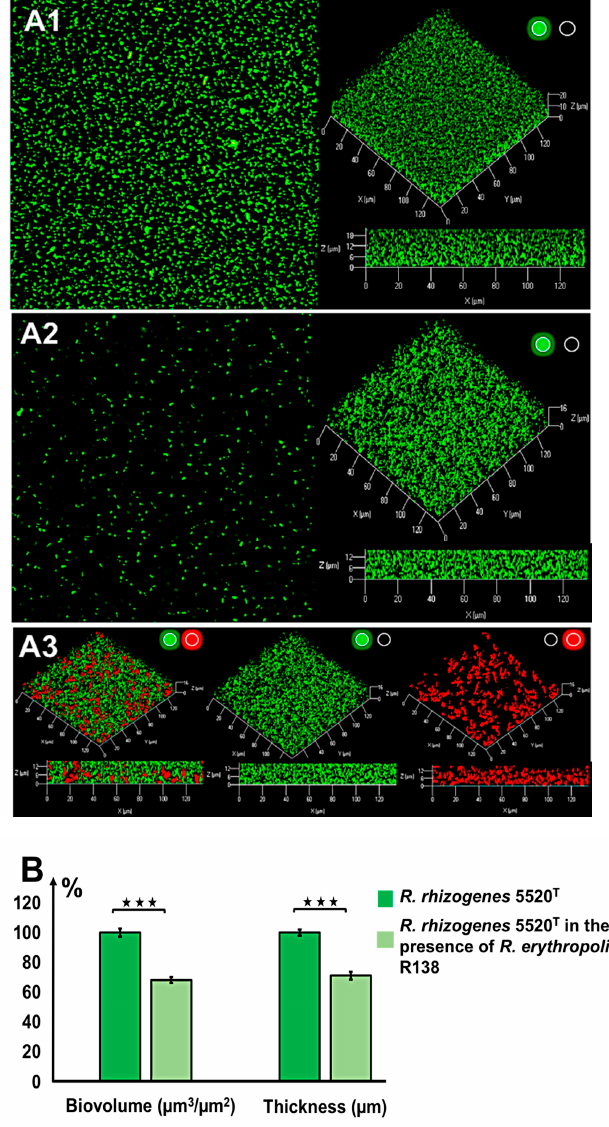
Figure 2. Inhibition of rhizobial biofilm formation by the biocontrol agent Rhodococcus erythropolis R138 (ratio 1:1). Biofilms were developed during incubation at 25 °C for 48 h in LB under static conditions. Confocal laser scanning microscopy (CLSM) analysis of the R. rhizogenes 5520 T biofilm ( A1 ) or dual-species biofilm formed by R. rhizogenes 5520 T (green fluorescence) and R. erythropolis R138 (red fluorescence) ( A2 , A3 ) was achieved at an inoculation ratio of 1:1. R. rhizogenes and rhodococcal bacteria were tagged with green fluorescent protein (GFP) and mCherry via the pHC60- gfp and pEPR1- mCherry vectors, respectively. Top view, 3D shadow representation, and side view of the biofilm produced by R. rhizogenes alone ( A1 ), and by a mixed culture of R. rhizogenes and R. erythropolis ( A2 ) analyzed in the green channel. Location of rhodococcal cells was revealed by 3D shadow representation and side view of the biofilm produced by the mixed culture analyzed in the red plus green, green, or red channels ( A3 ) (activation of the green or red channel is indicated by a light spot of the corresponding color). COMSTAT analyses of R. rhizogenes green fluorescence in single- and dual- species biofilms. R. rhizogenes biofilm biomass and thickness values were normalized (set to 100%) as a reference for a comparison with mixed biofilm conditions ( B ). The data shown are the means of three measurements from three independent experiments. Significant differences (Mann–Whitney test; p -value < 0.01) in biovolume and thickness are indicated by asterisks ( (cid:70)(cid:70)(cid:70) p <